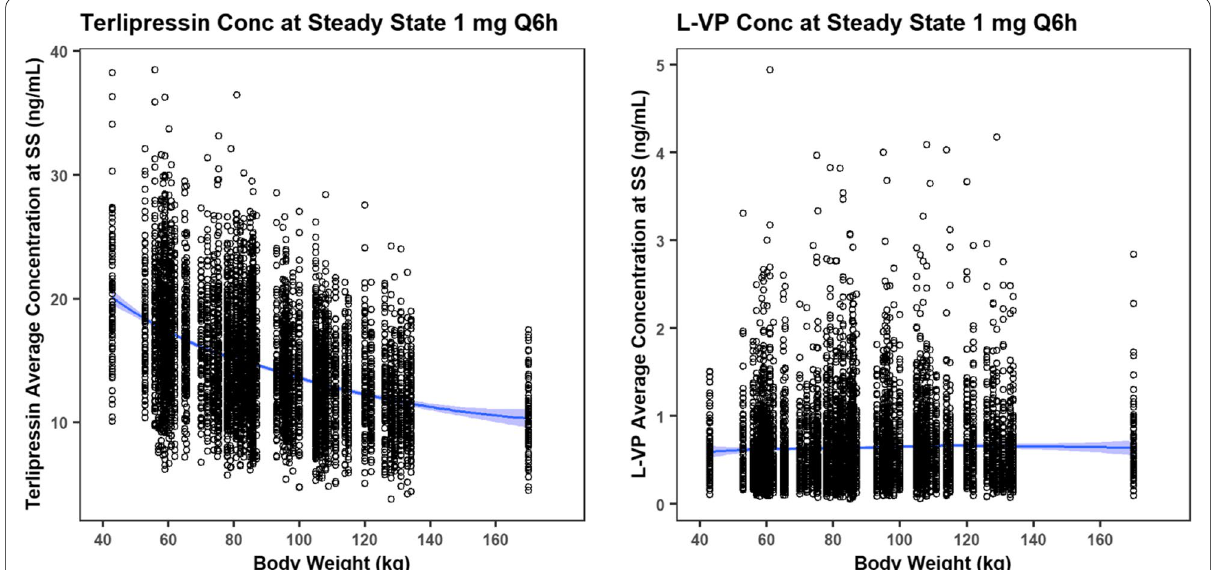
Fig. 4 Simulated terlipressin and L-VP plasma concentrations at steady state following terlipressin 1 mg administered every 6 h in patients with HRS with different body weights. The solid blue line indicates the Loess fitting and the shaded area indicates the 90% confidence interval. Conc , concentration; HRS , hepatorenal syndrome; L-VP , lysine-vasopressin; Q6h , every 6 h; SS , steady-state